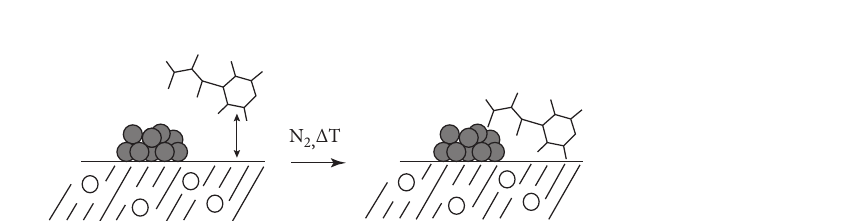
Figure 3: Representation of cinnamaldehyde adsorption after removing the functional groups containing oxygen, thus improving the catalytic performance of CNF supported Pt